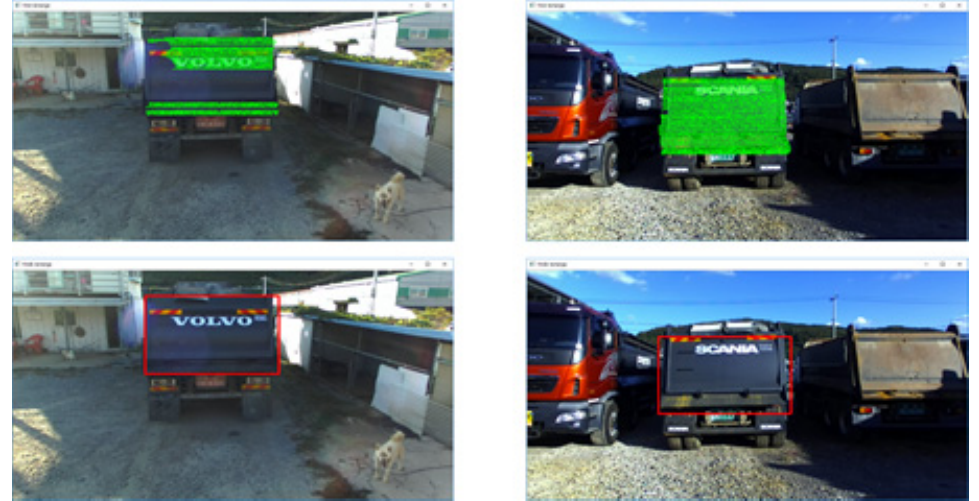
Figure 20. The result of detecting the doors of two commercial dump trucks with LiDAR data. The green point cloud is the point cloud obtained from the stereo camera projected onto the dump truck door plane.